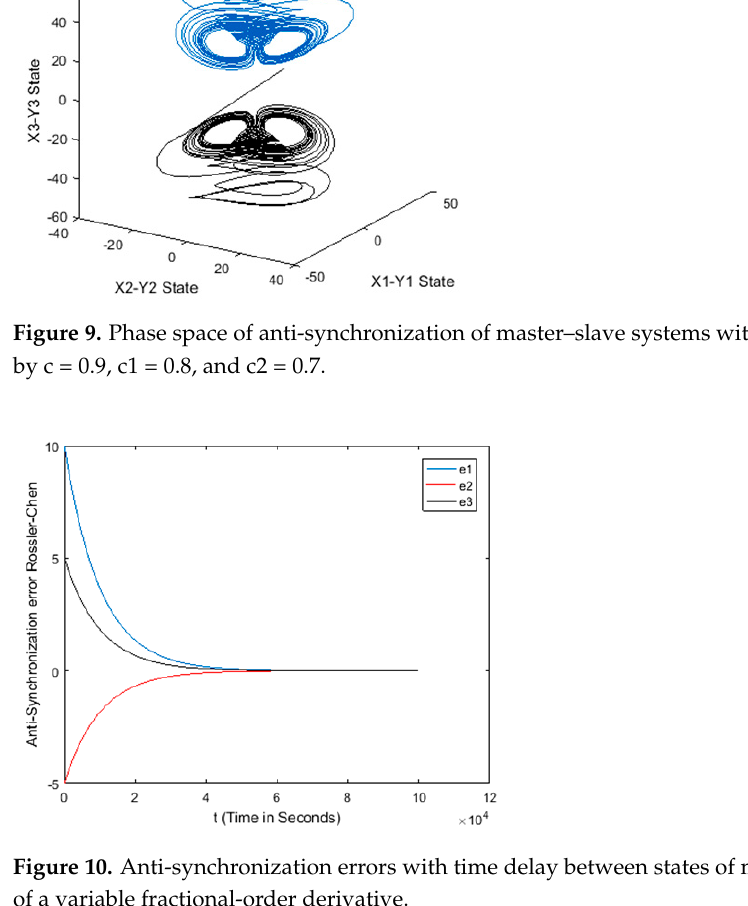
Figure 10. Anti-synchronization errors with time delay between states of master and slave systems of a variable fractional-order derivative.